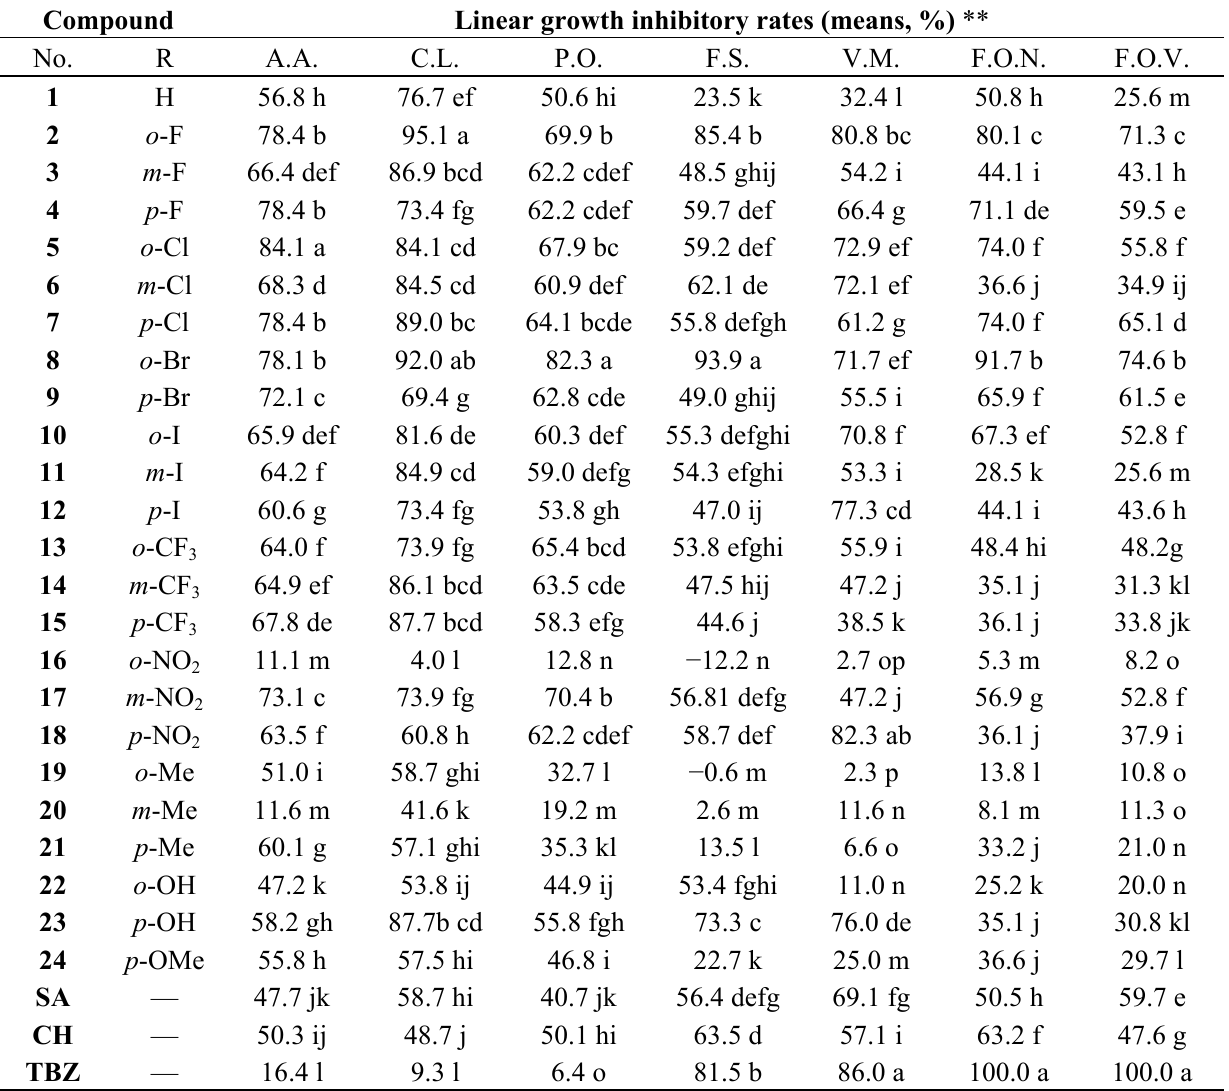
Table 1. Substituent patterns and antifungal activities of compounds at 50 μ g/mL (72 h). *